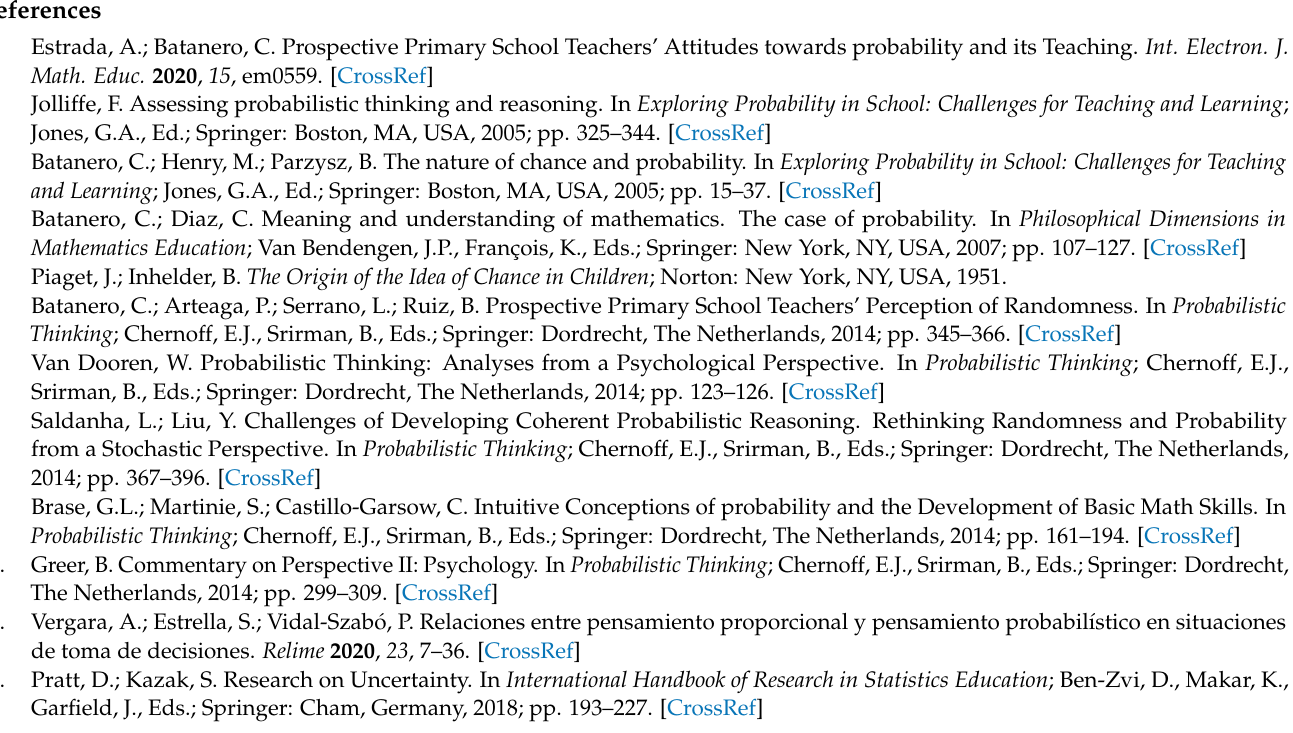
Figure A1. Task. Figure A1.